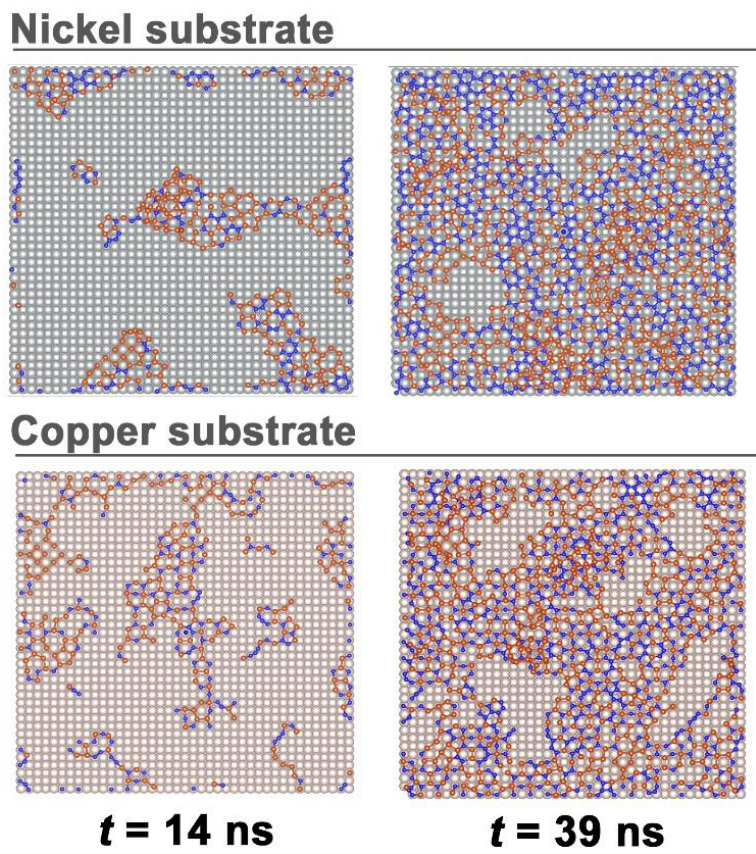
Figure 2. Stages of growth of SiC films on metal substrates: nickel ( top ) and copper ( bottom ); in the figures on the right, the SiC film largely covers the corresponding substrate.